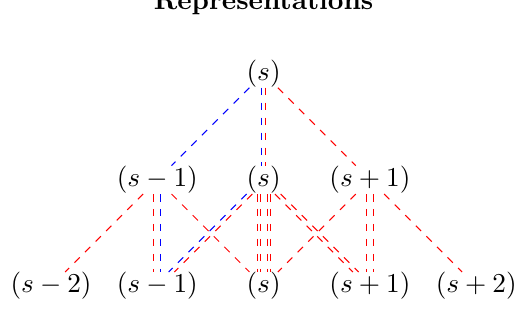
Figure 1 . The possible non-linear symmetries that can be realised on a spin- s Lorentz representa- tion and their links via space-time